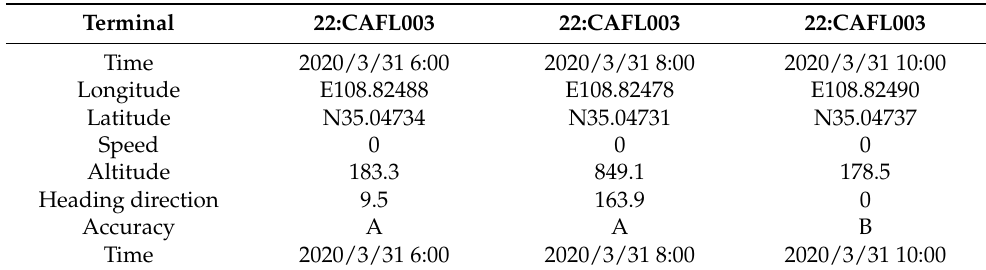
Table 1. Example of crested ibis’s trajectory